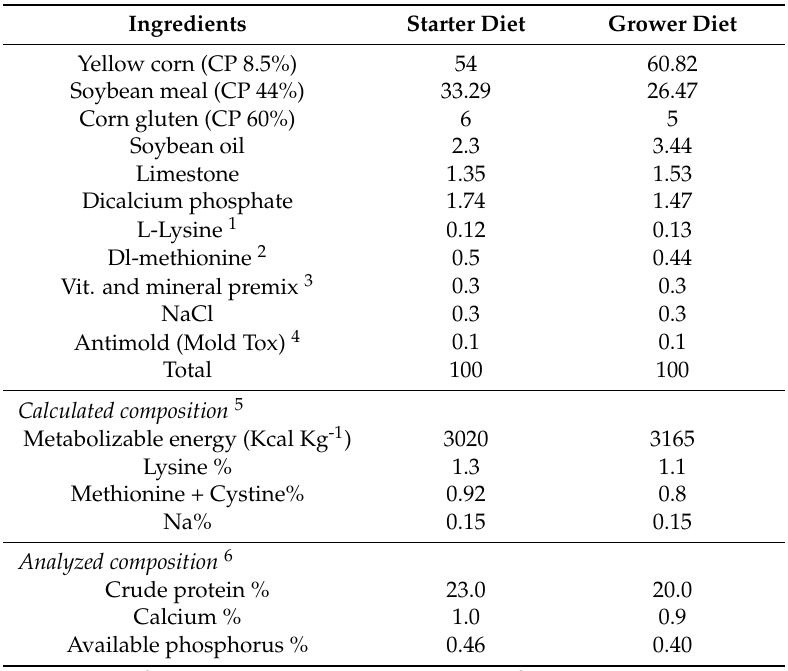
Table 1. Ingredients and nutrient composition of the diets (as-fed basis).